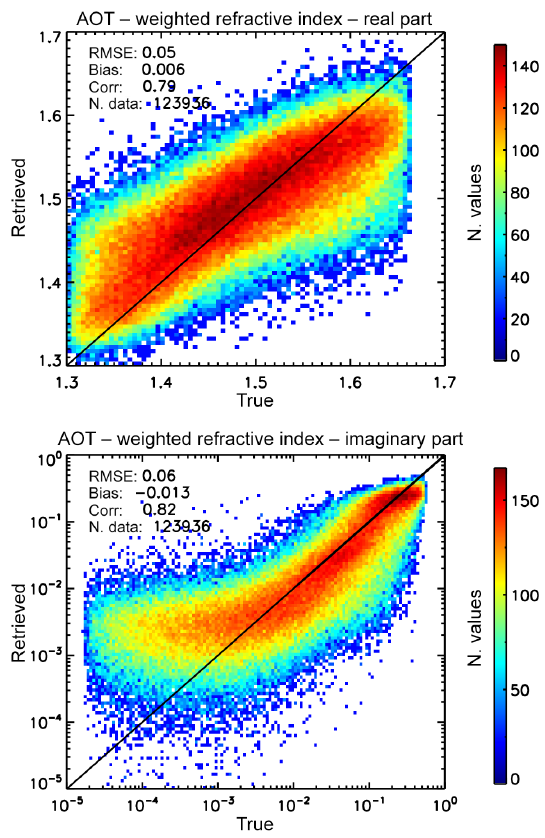
Figure 6. Neural network retrieved versus true real and imaginary part of the refractive index, weighted by mode AOT. Synthetic data. Only cases with total AOT larger than 0.1 are shown.